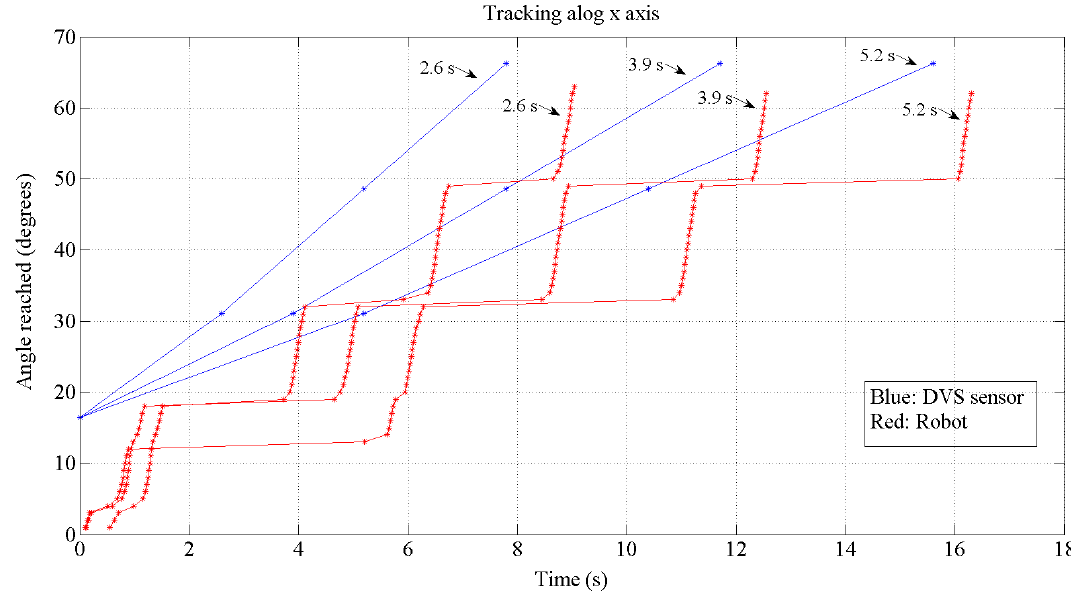
Figure 18. Angle vs . time tracked for the x-axis. The input is a go and return along the x-axis in the frame of reference of the retina. The red points show the angle trajectory followed by the robot and the blue points show the targets delivered to the